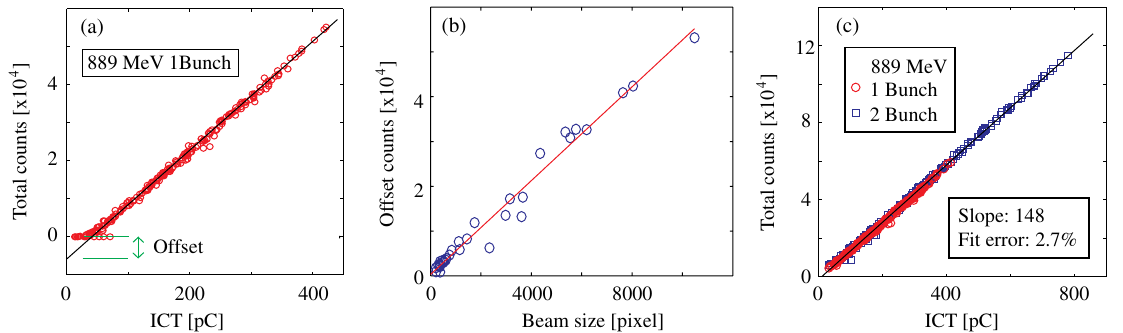
FIG. 5. (a) Typical charge scan results (circles). The horizontal axis is the charge measured by the ICT, and vertical axis is the total counts on the CCD camera. The electron energy was 889 MeV, and one microbunch was used. The solid line is a linear fit. The offset of the CCD counts is indicated by the arrow. (b) The observed offset CCD camera counts as a function of the beam size in terms of the number of pixels for 15 different energies with one and two microbunches (circles). The solid line is a linear fit. (c) The total counts on the CCD camera as a function of the charge measured by the ICT for 889 MeVelectron energy, circles: one microbunch; squares: two microbunches. The solid line is a linear fit, and the slope and the fit error defined by Eq. (1) are shown in the lower right inset. The total counts on the CCD camera were biased based on the modeled offset shown in (b), and only points with the signal to noise ratios for ICT SN and CCD camera image SN above 10 were taken into ict img